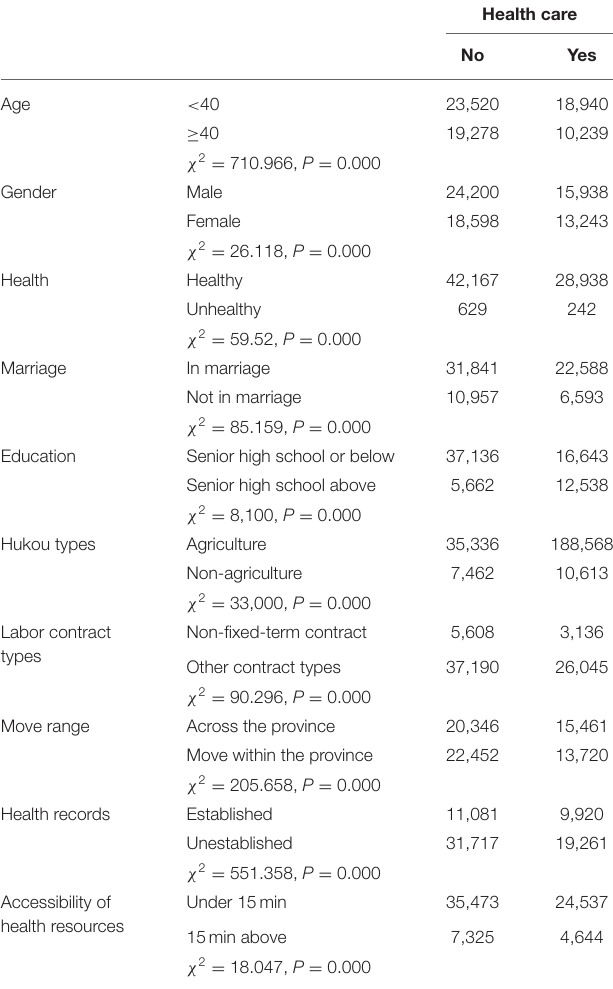
TABLE 4 | Health insurance coverage by migrants’ characteristics ( N =